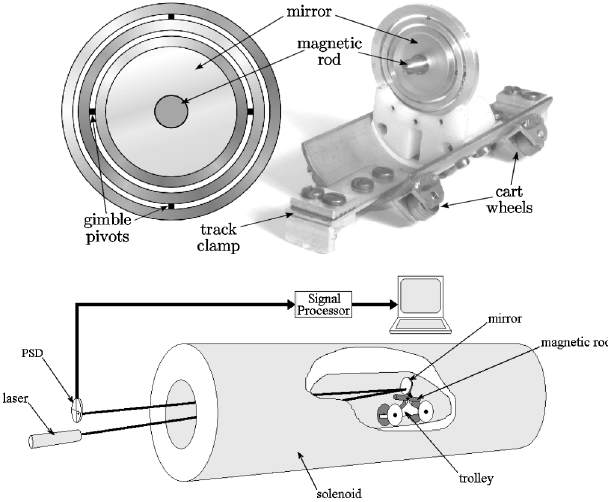
FIG. 6. (top) Drawing of the gimble and photograph of the cart. The gimble measured only 2.54 cm across and has very little mechanical resistance. The cart was pulled by a long track, and it rolled inside an aluminum pipe temporarily thrust into the solenoid bore; (bottom) simplified cartoon illustrating the tech- nique used to measure the magnetic field line straightness in the main The field lines in the center of the solenoid are shown in Fig. 7. In the (cid:1) 100 cm of the interaction region, the field does not bend more than 200 (cid:4) m in the horizontal direc- tion and only about 45 (cid:4) m in the vertical. The rms devia- tions of the magnetic lines are 15 (cid:4) m in the vertical plane and 50 (cid:4) m in the horizontal plane. Therefore the electron beam is able to surround the antiproton bunches through the entire solenoid length. The 200 (cid:4) m variation is con- veniently small and allows the option to experiment with beam-beam compensation at different electron-beam sizes. The deviation of the straightness of the field lines change as the solenoid’s field is ramped up or down is found not to exceed 20 (cid:4) m . The solenoid field lines as far as (cid:1) 1 mm away from each other are measured to be parallel within (cid:1) 6 (cid:4) m [9].